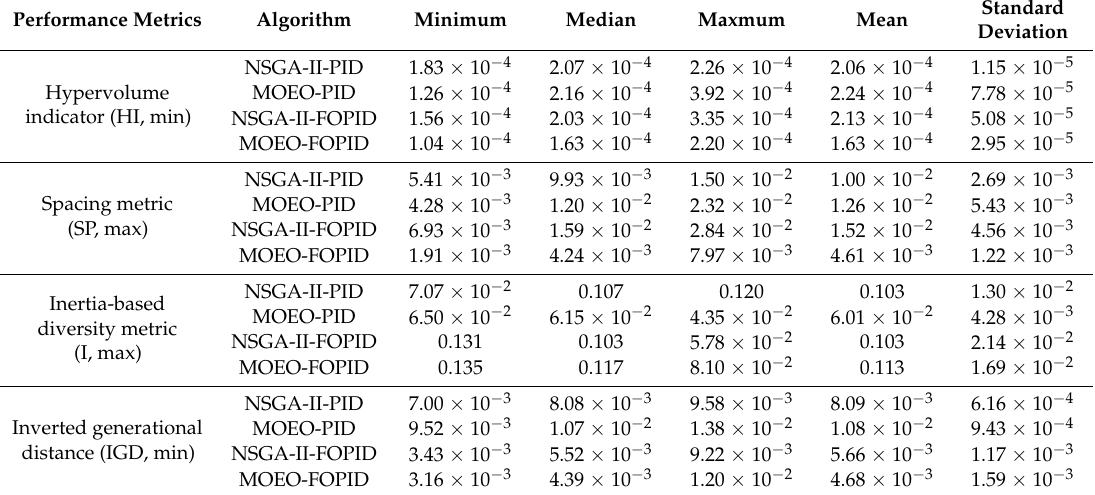
Table 4. Comparison of the statistical performance metric for Pareto fronts obtained by MOEO-FOPD/PID and NSGA-II-FOPID/PID for